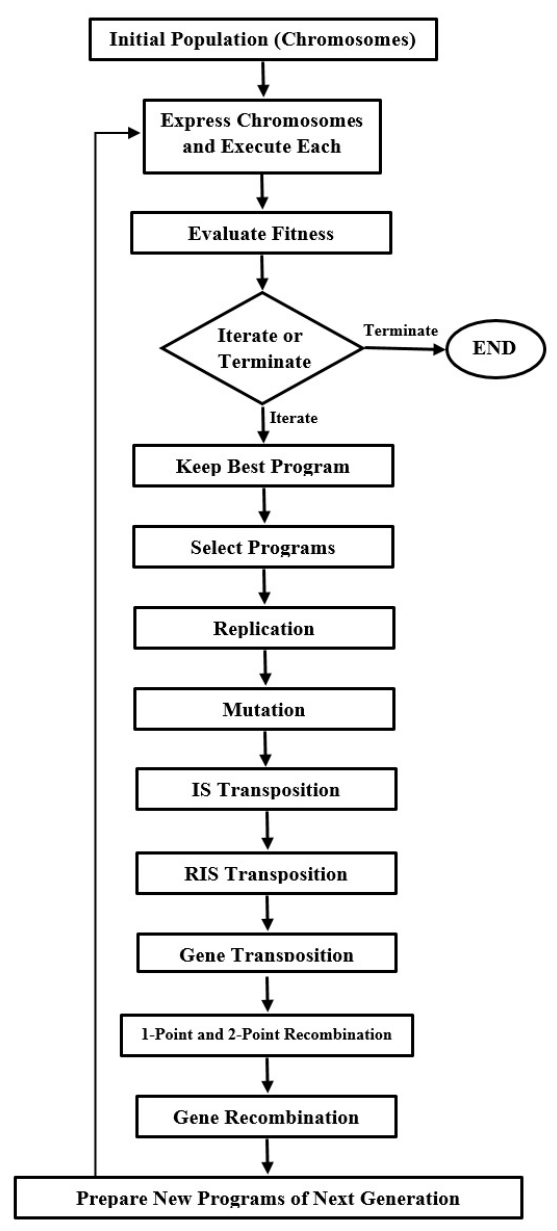
Figure 4. The flowchart of a gene expression algorithm.